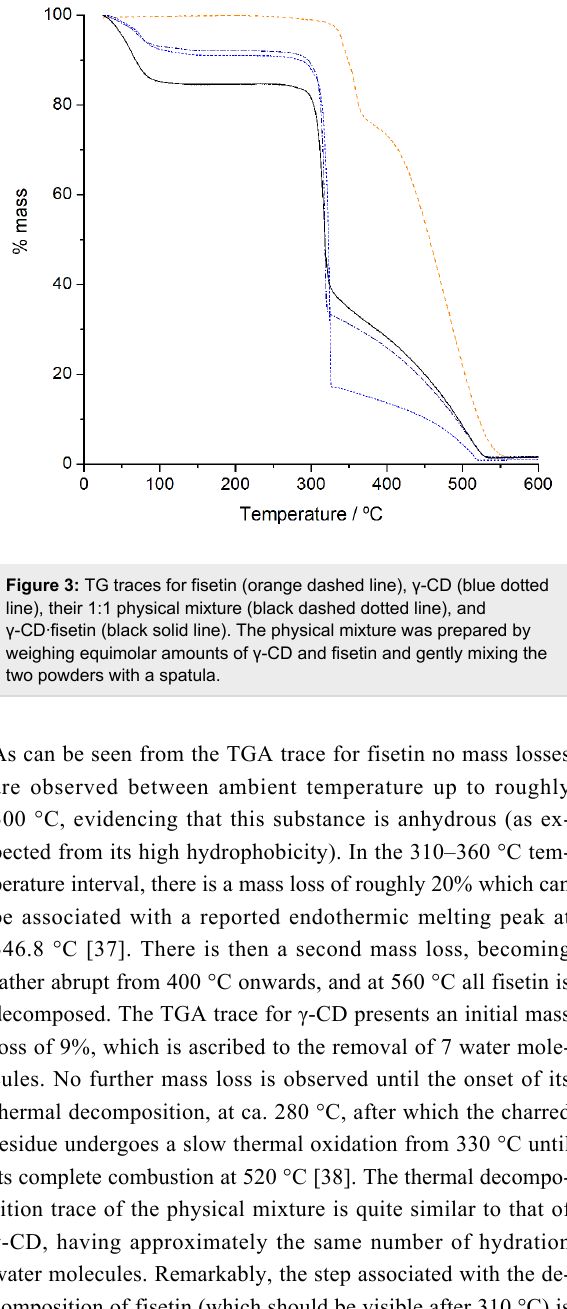
single signals. Such is the case of C1 and C6, while the signals of C4 and C2, 3, and 5 appear each as a sharp resonance with a shoulder of lower intensity. In agreement with the structural